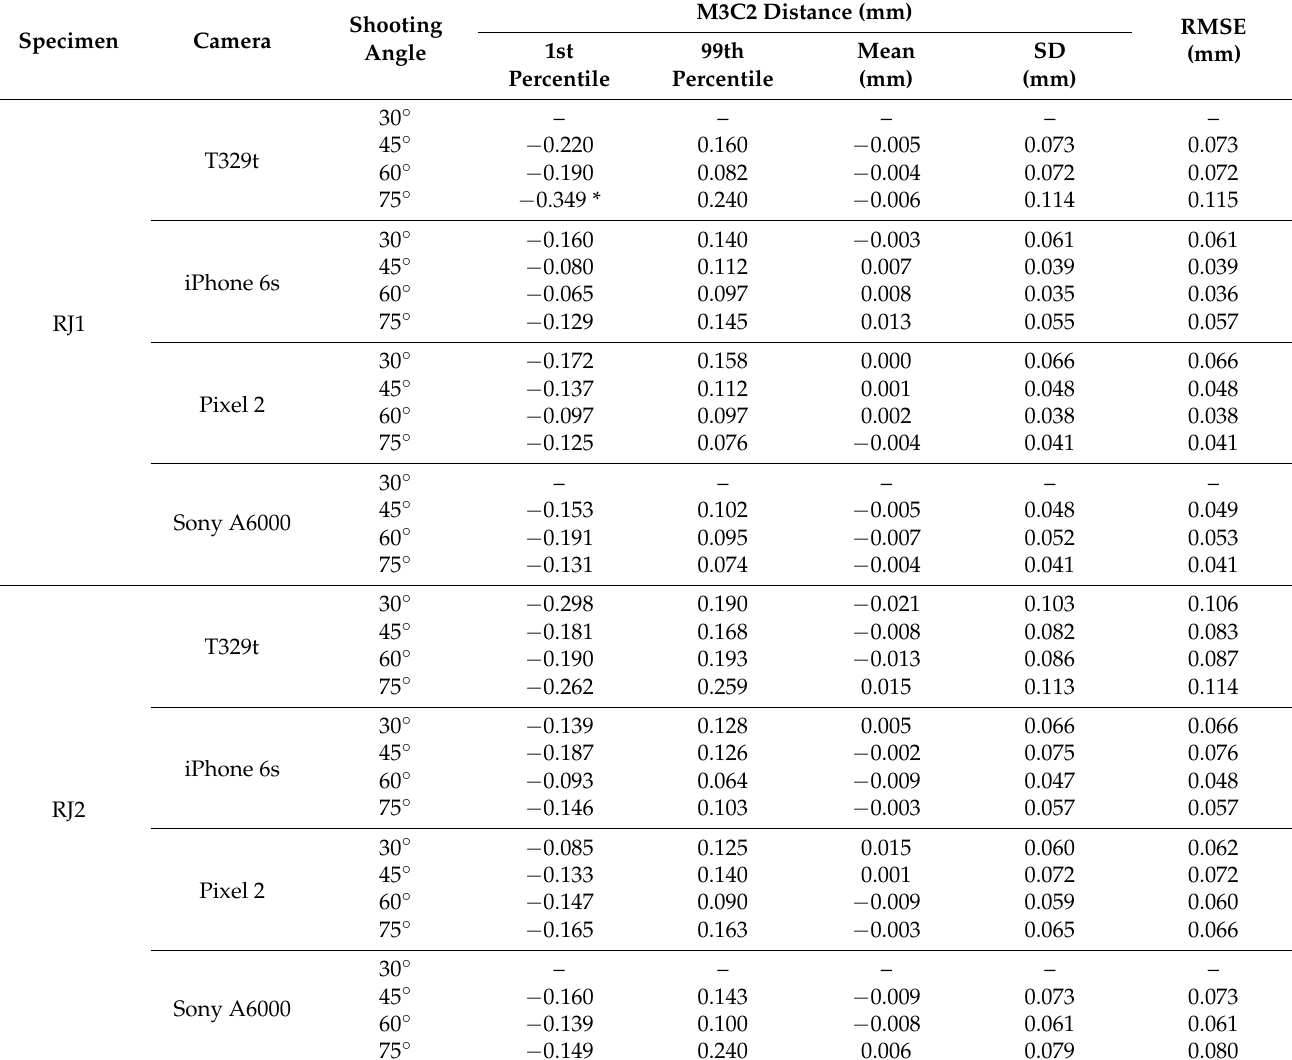
Table 6. The M3C2 distance between the HLS model and SfM model under the FSC mode.